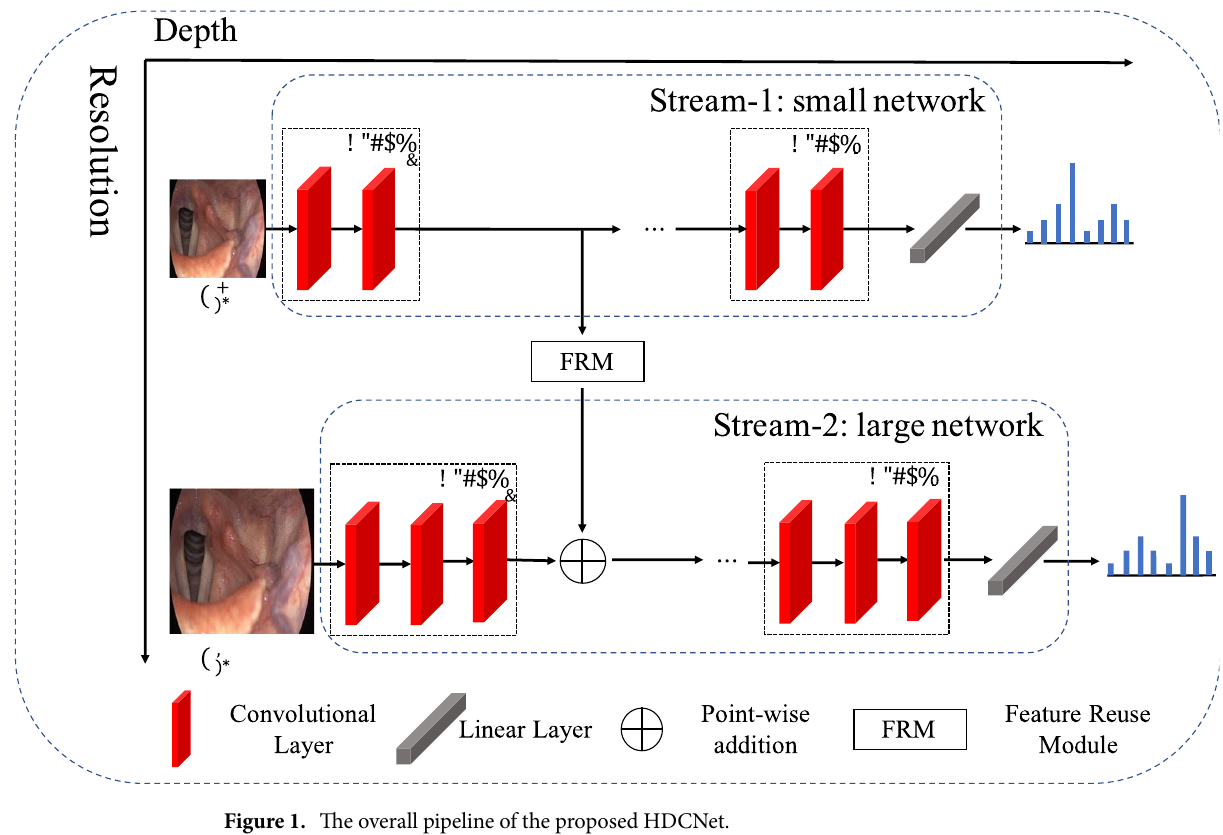
Figure 1. The overall pipeline of the proposed